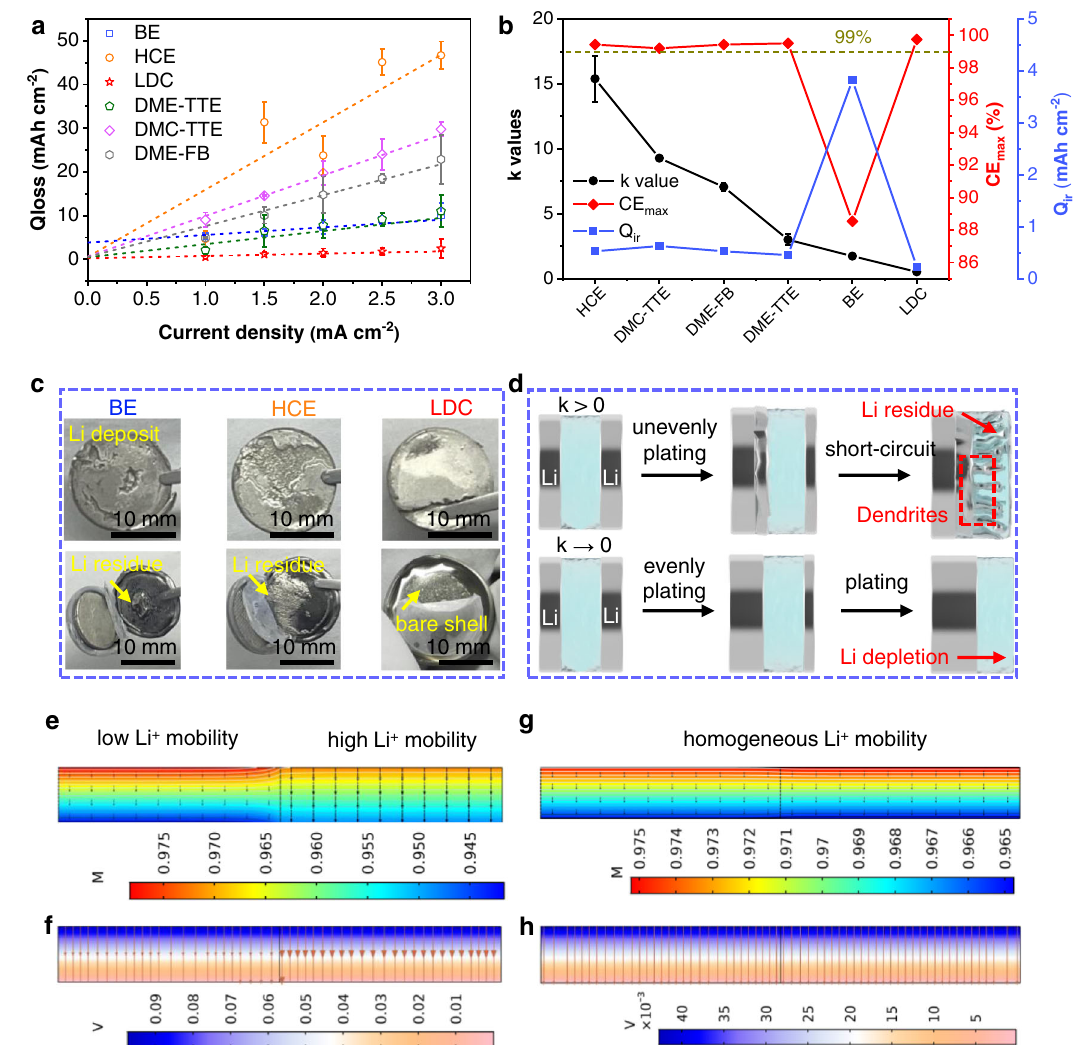
k → 0. The simulation results of Li + concentration and potential distribution across Q theLiF-richSEI( e , f )anddualLiF 1- x Cl x -richSEI( g , h ).Allerrorbarsareevaluatedby max , and ir for different standard